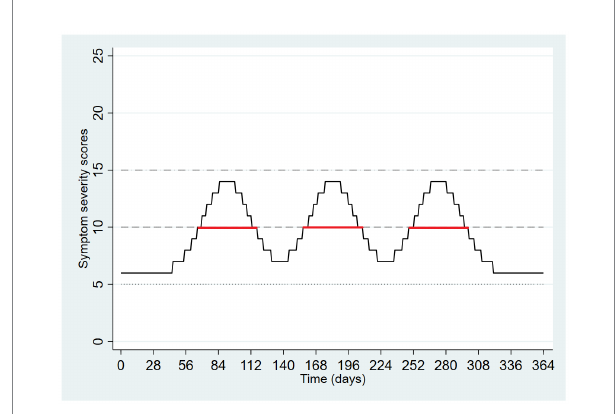
FIGURE 1 Hypothetical pattern of symptom severity over one year, with application of three symptom severity thresholds.